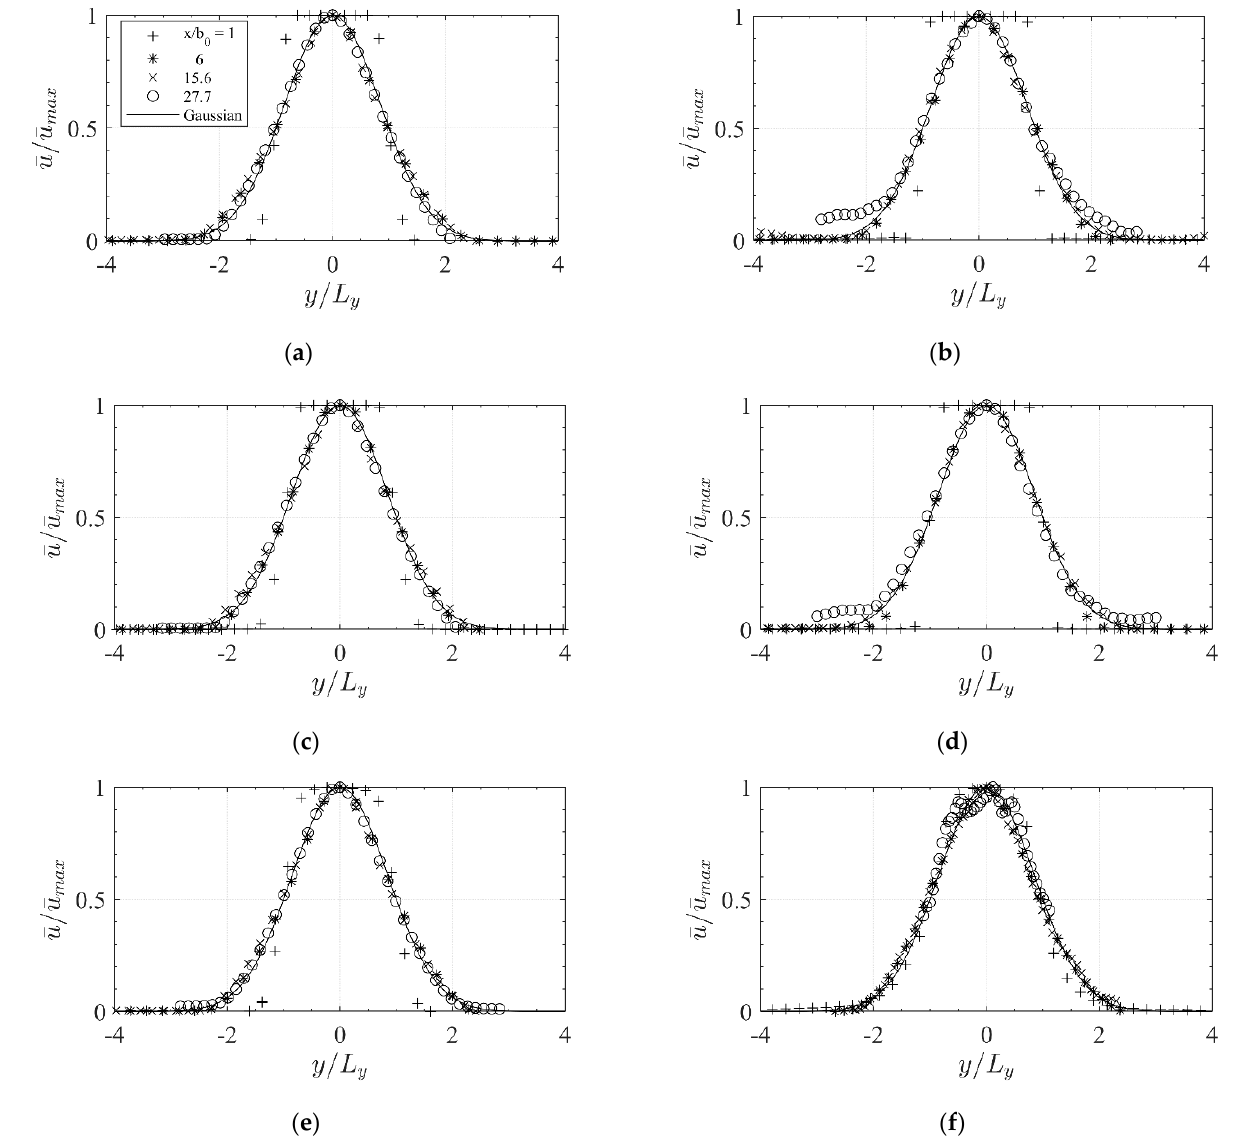
Figure 12. Distribution of time-averaged normalized streamwise velocity u / u max at different x / b 0 at z = 0.5 h 0 m for